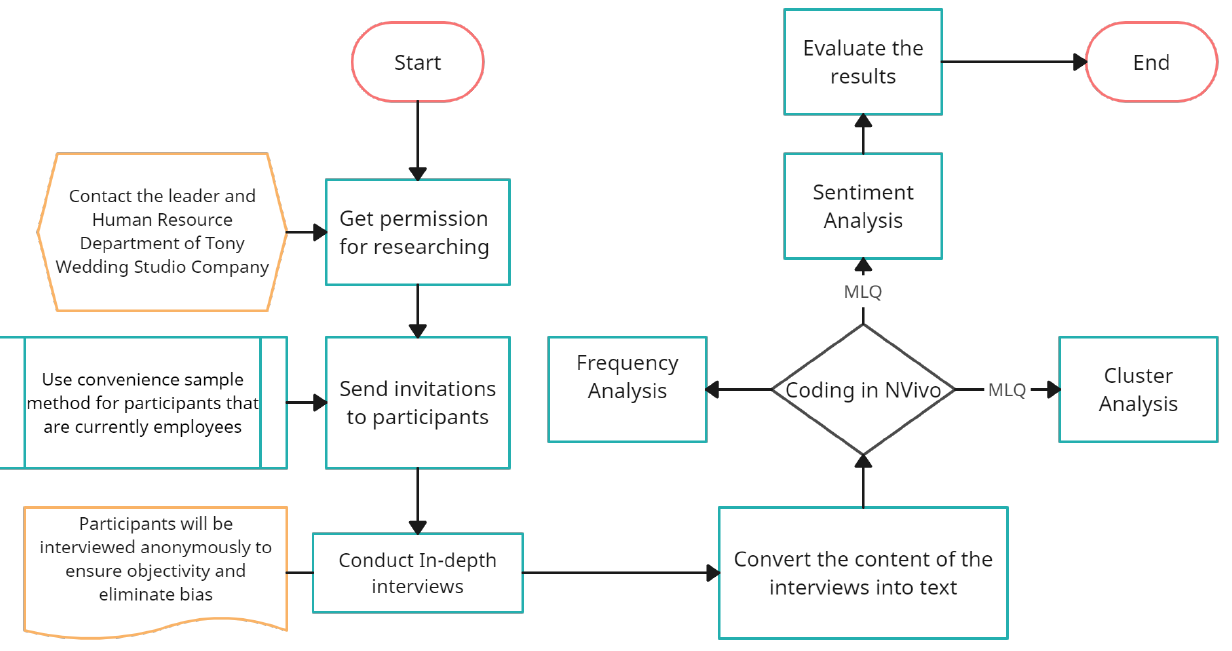
Figure 1. Research Flowchart.